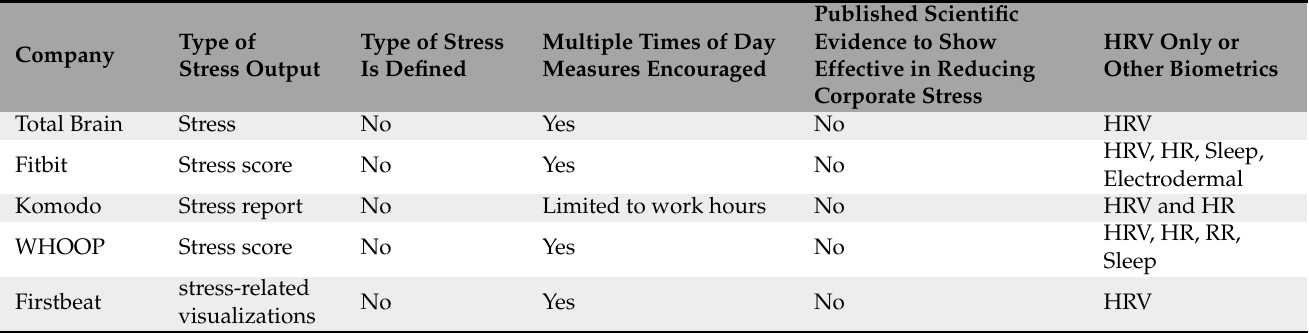
Table 1. A comparison of HRV platforms using open access information (web and scientific published literature). Here we provided the evidence and function of each HRV platform with respect to stress engagement for each commercial company assessed. Heart rate (HR); respiratory Rate